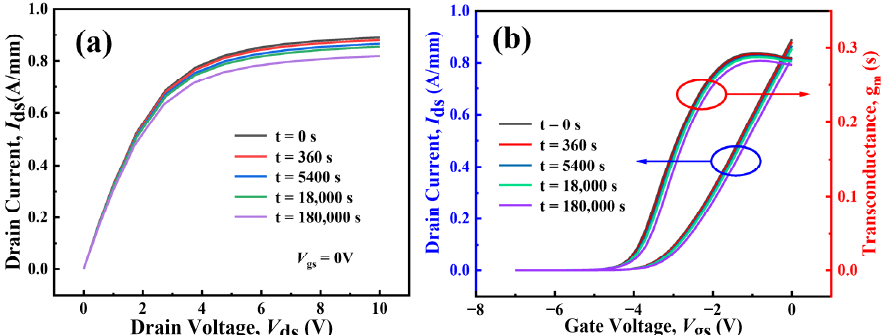
Figure 6. ( a ) I ‐ V curve degradation of GaN HEMTs with time at hot ‐ electron stress V ds = 30 V, V gs = − 1 V and ( b ) transfer and transconductance characteristic degradation of GaN HEMTs.